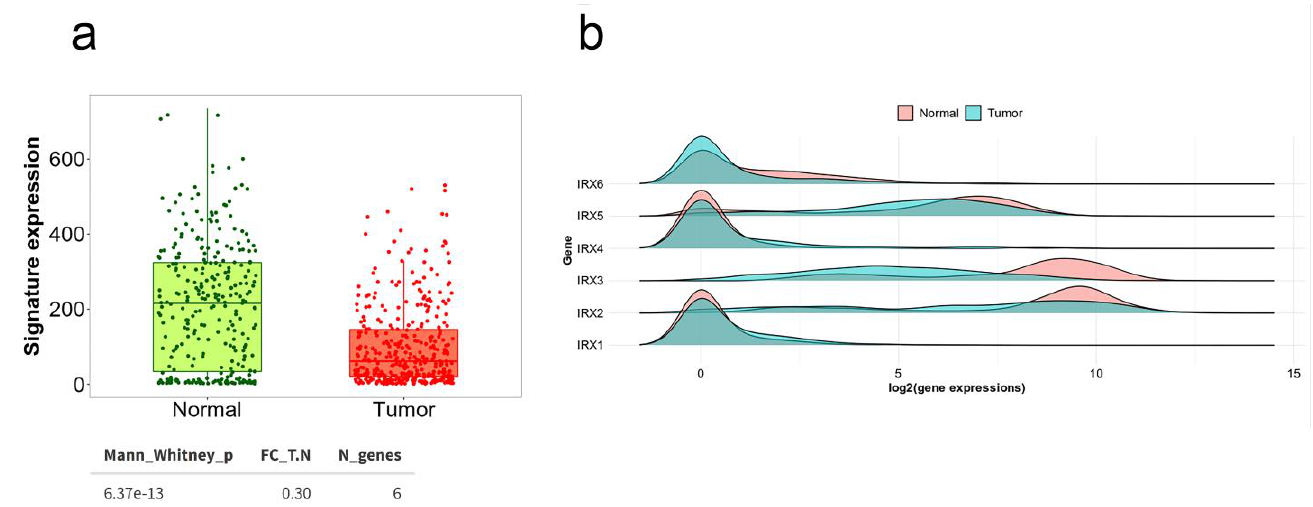
Figure 4. The expression signature of Iroquois genes in GC patients. ( a ) The gene signature analysis page calculates the means of the selected gene signature across each patient one by one and provides a summary plot using RNA-Seq-based data. ( b ) Multiple gene analysis provides an overview of the selected gene set in the selected tissue using RNA-Seq-based data.